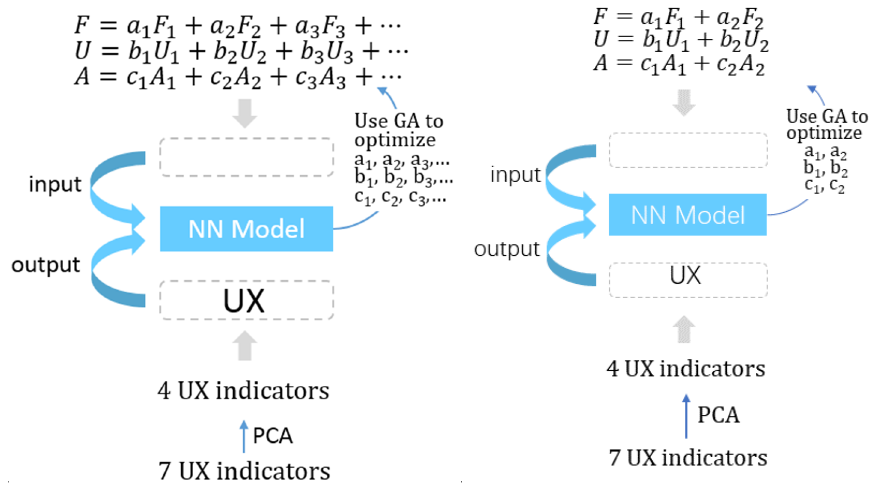
Figure 6. Proposed model with multiple linear superposition and NN.